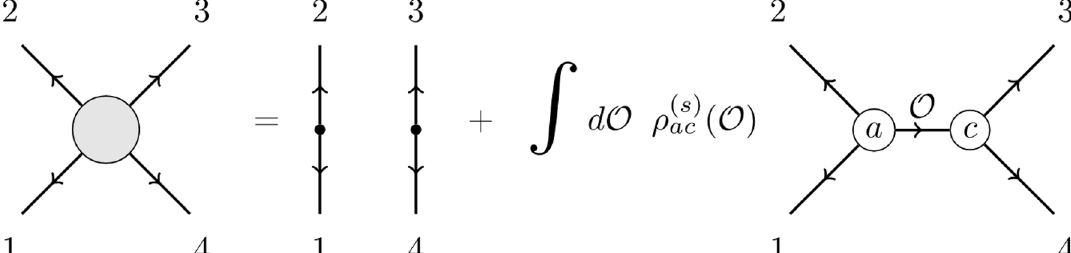
Figure 6 . Diagrammatic illustration of the s-channel partial wave expansion of the four-point function, assuming that the identity contribution is the only non-normalizable contribution. Instead of separating it, we can deform it onto the principal series and deform back after the analytic continuation from principal series to physical